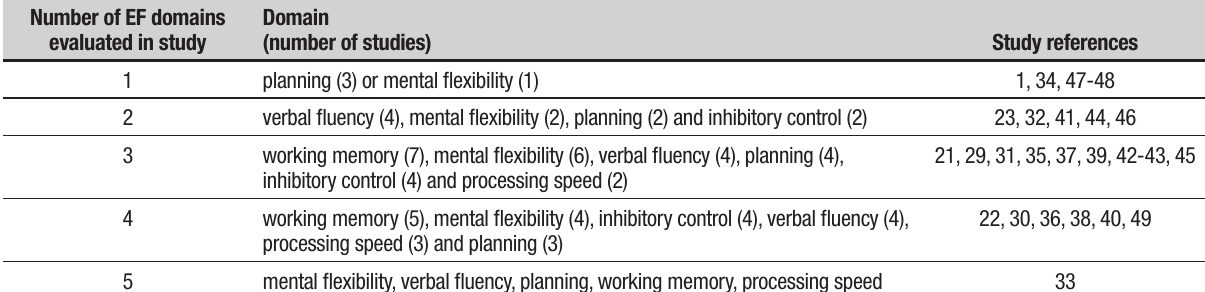
Table 3. Frequency of studies by number of domains used to evaluate executive functions in aging research. Number of EF domains Domain evaluated in study (number of